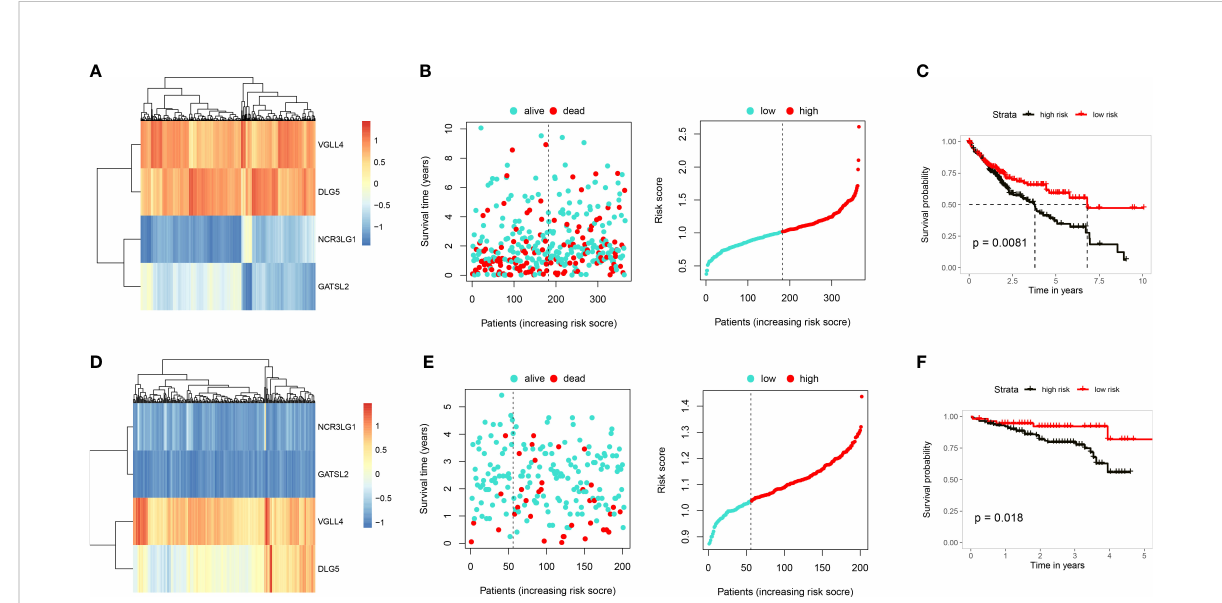
FIGURE 6 Construction and validation of a cuproptosis prognosis model. (A) Heatmap showing gene expressions in the cuproptosis prognosis model including, VGLL4, DLG5, NCR3LG1 and GATSL2 in TCGA-LIHC. (B) Distribution of risk scores and survival status of TCGA-LIHC. (C) Results of KM analysis indicating that the prognosis model signi fi cantly in fl uenced survival of patients in TCGA. Dark line represents the high-risk group and red line the low-risk group. (D) Heatmap showing gene expressions of the cuproptosis prognosis model in ICGC. (E) Distribution of risk scores and survival status of ICGC. (F) Results of KM analysis indicating that the prognosis model signi fi cantly in fl uenced survival of patients in TCGA. Dark line represents the high-risk group and red line the low-risk